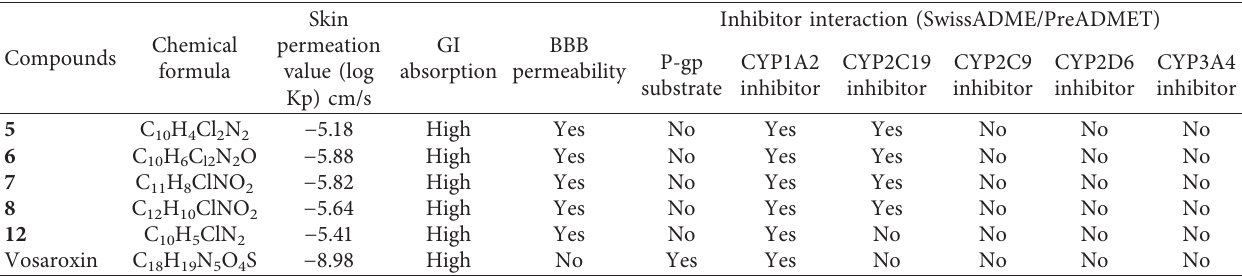
Table 6: ADME predictions of compounds 5 – 8 and 12 computed by SwissADME and PreADMET. Chemical Compounds formula